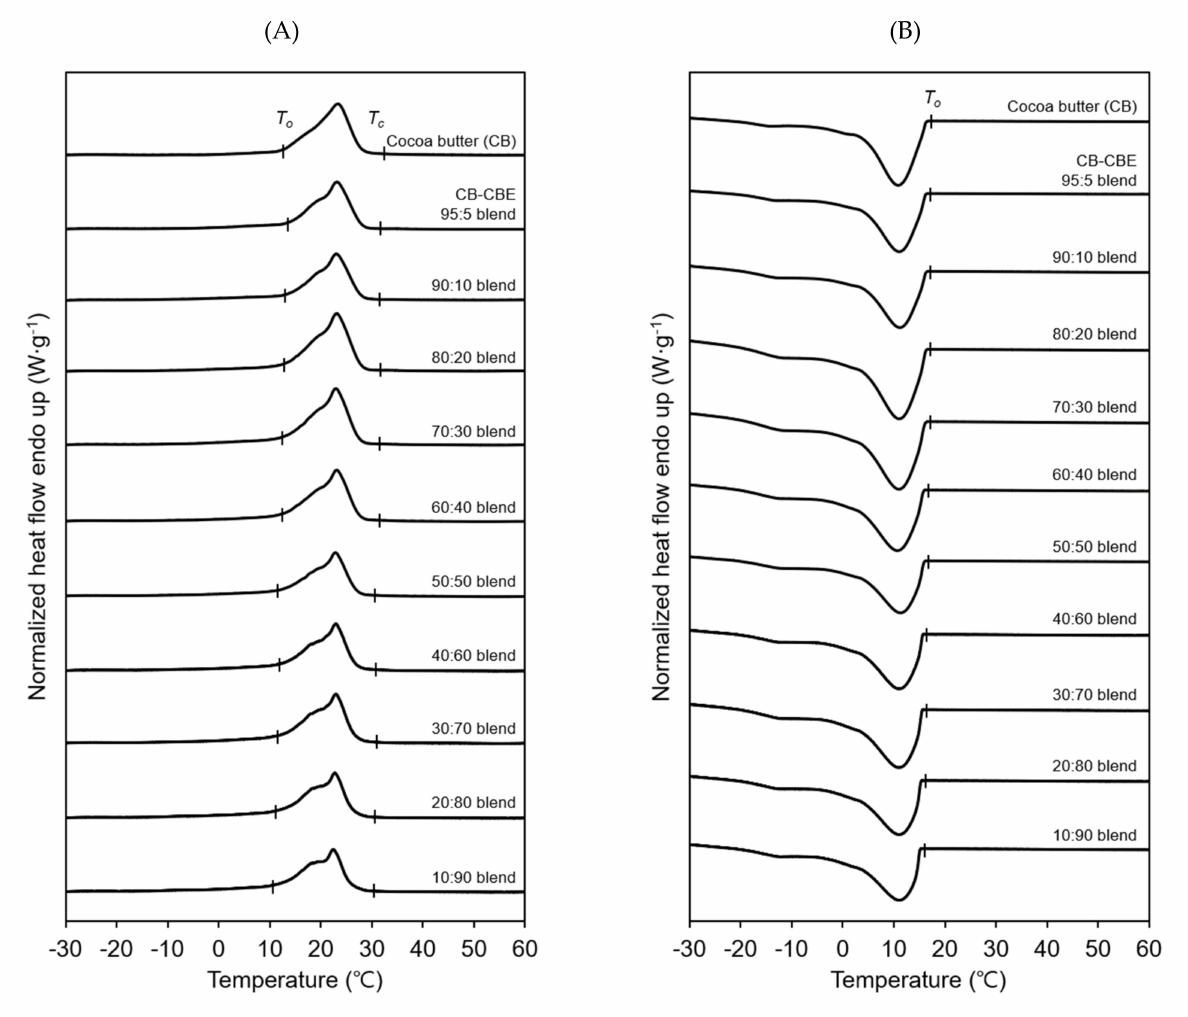
Figure 6. DSC melting ( A ) and crystallization ( B ) profiles of cocoa butter and cocoa butter–cocoa butter equivalent (CBE) blends with different cocoa butter:CBE weight ratios ranging from 95:5 to 10:90. T o and T c indicate the onset and completion temperatures of melting or crystallization, respectively.